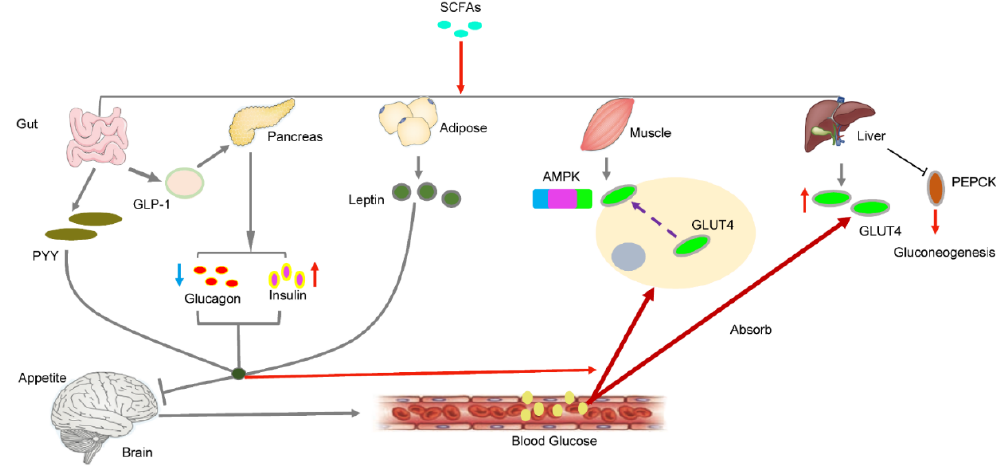
Figure 2. SCFAs regulates blood sugar by regulating the secretion of hormones in different